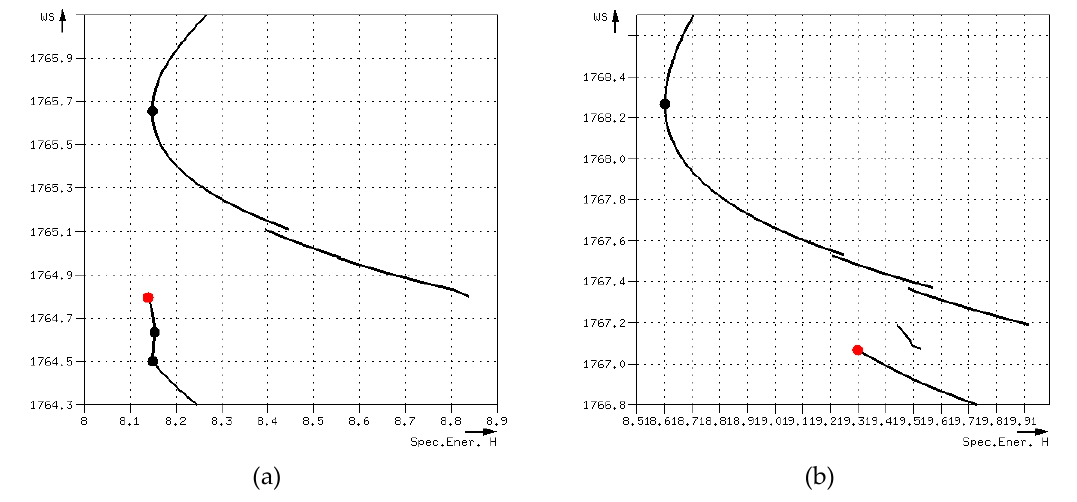
Figure 19 . Dataset 4: Critical depths for ( a ) case 4 section 12 and ( b ) case 5 section 15